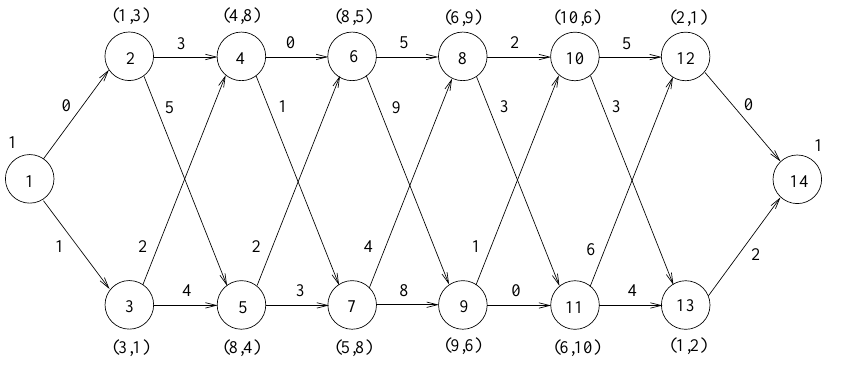
Figure 6: The layered graph, L 0 , corresponding to the initial solution seqence S 0 = h (1 , 3) , (4 , 8) , (8 , 5) , (6 , 9) , (10 , 6) , (2 , 1) i of the RPP instance in Example